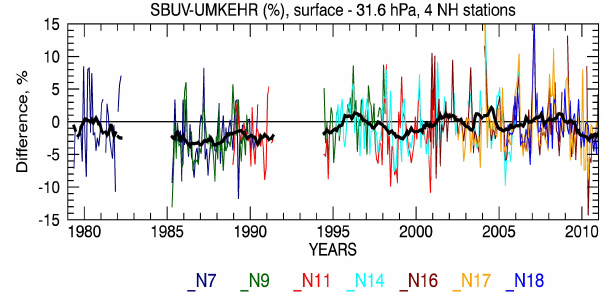
Fig. 10. Time series of differences between SBUV and an ensemble of four northern midlatitude Umkehr instruments in the layer be- tween surface and 30hPa. The ensemble includes Umkehr data from Belsk (52 ◦ N), Arosa (47 ◦ N), Boulder (40 ◦ N) and Haute Provence (44 ◦ N). Colors correspond to individual SBUV instruments.